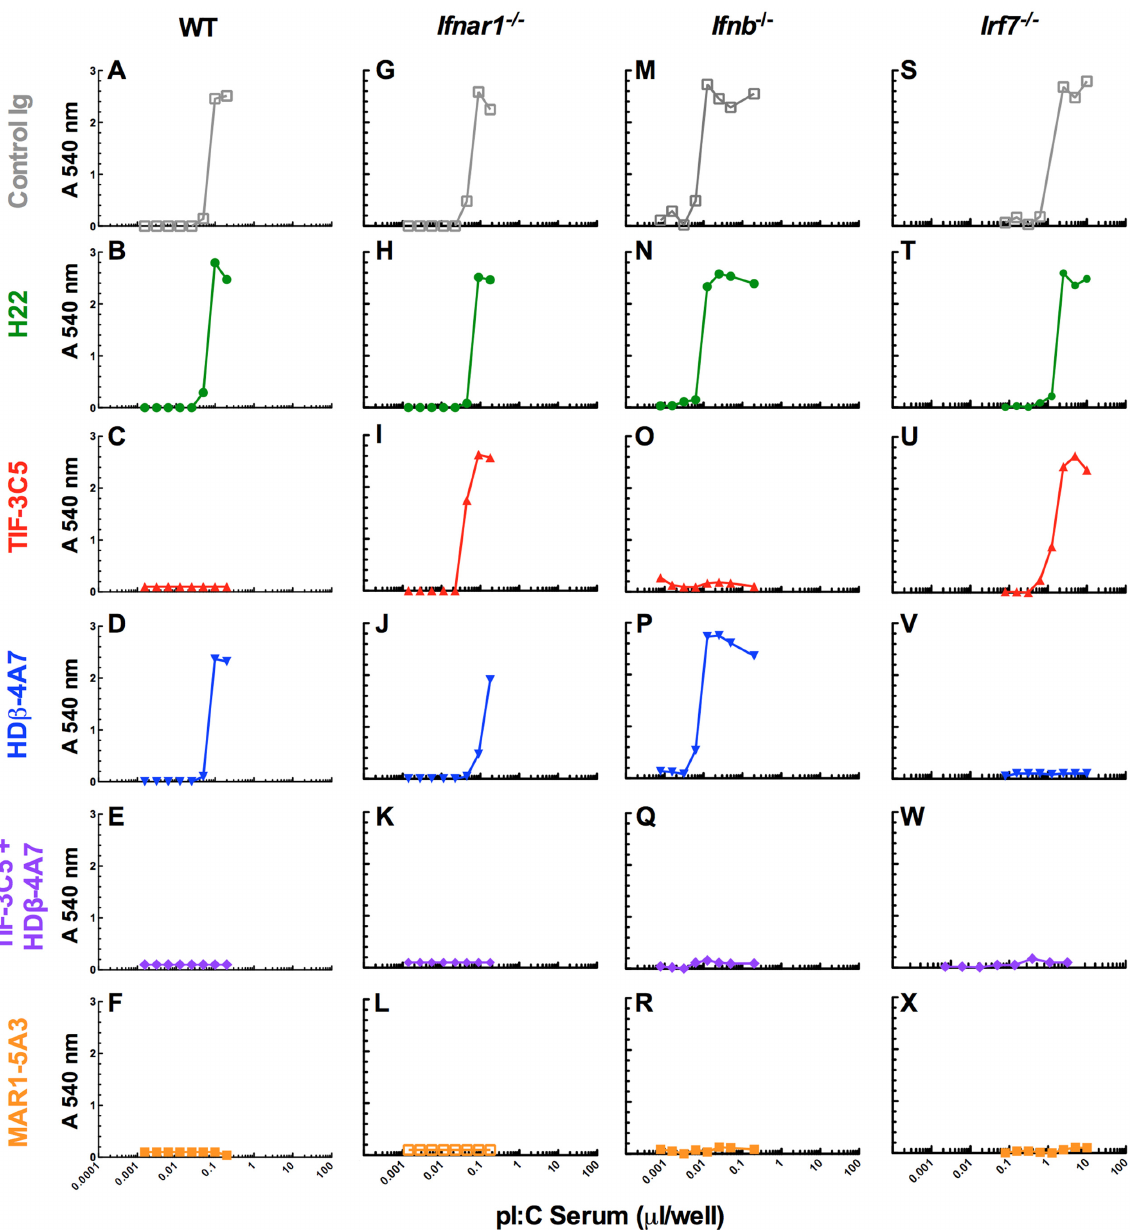
Fig 6. Detection of IFN- β and IFN- α in serum following pI:C treatment. Serum was collected from wild-type ( A-F ), Ifnar1 -/- ( G-L ), Ifnb -/- ( M-R ) or Irf7 -/- ( S-X ) mice injected with 100 μ g of pI:C at 3 to 6 hrs. Volumes of serum containing approximately 5 – 10 units of IFN activity (as determined in Fig 4) were incubated with 10 μ g of mAb for 1 h and then titrations were added to L929 cells overnight. IFN-treated cells were infected with VSV and cellular viability assessed after 48 h using crystal violet staining and optical density measurements. Each panel is representative of six independent samples.